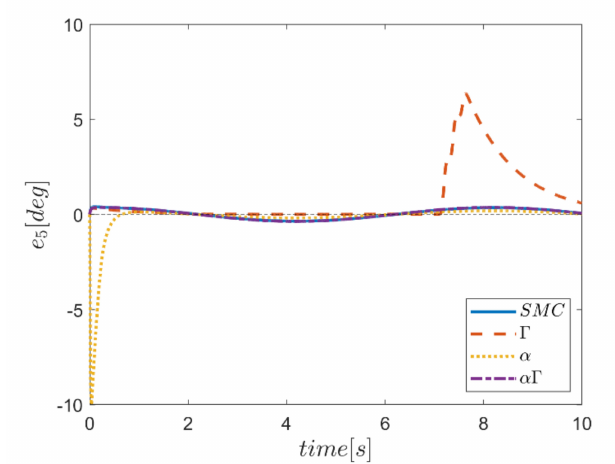
Figure 44. Tracking error in the θ